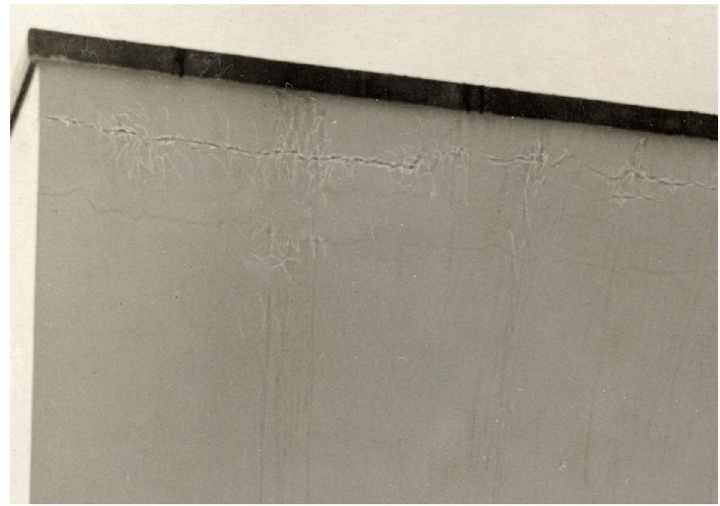
Fig. 7 Tugendhat House, Brno 1930, south east wall of Grete Tugendhat ’ s dormitory, detail: the crack between concrete roof and the brick wall,